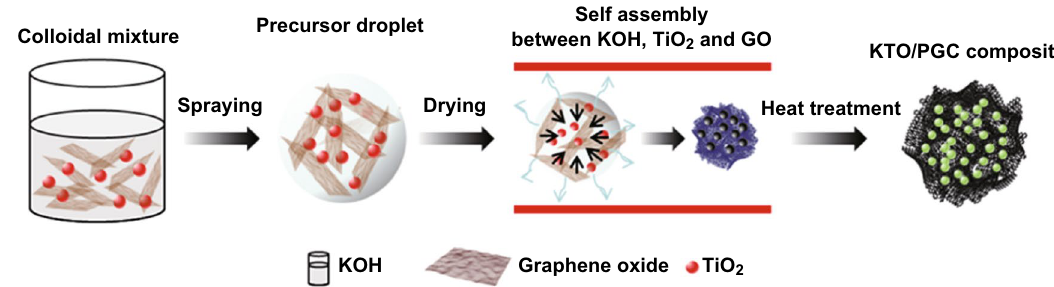
Fig. 1 Schematic illustration of the formation of KTO NP/PGC composites from a colloidal mixture of TiO 2 , KOH, and GO via aerosol spray pyrolysis and post‑heat